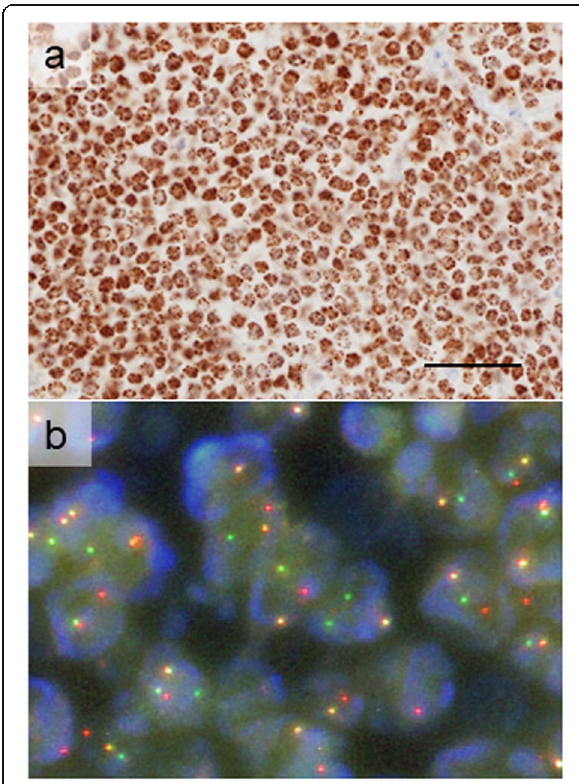
Fig. 4 NUT immunohistochemistry and Fluorescence in situ hybridization. a NUT immunohistochemistry. Diffusely positive tumor nuclei with a speckled pattern. Bar, 100 μ m. b Fluorescence in situ hybridization (FISH). The BRD4-NUT fusion gene was